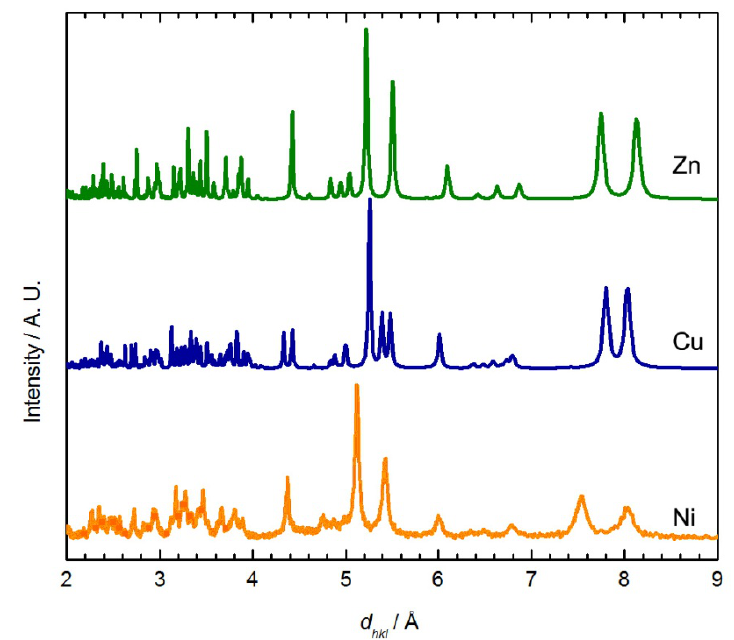
] (DMSO) polymorph (Cu, 2 2 2 ] (DMSO) (Ni, 2 2 2